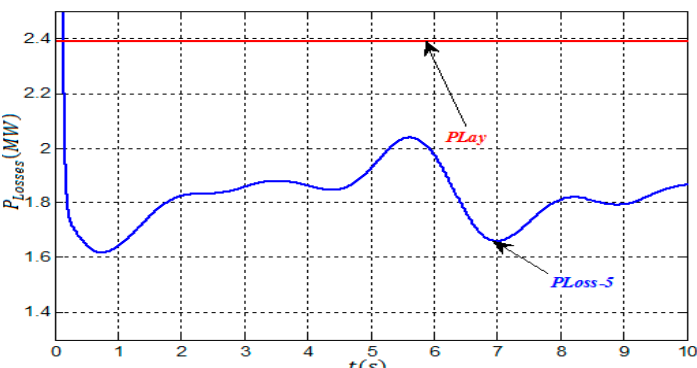
Figure 15. Comparison of annual average real power losses by the analytical method and Simulink.